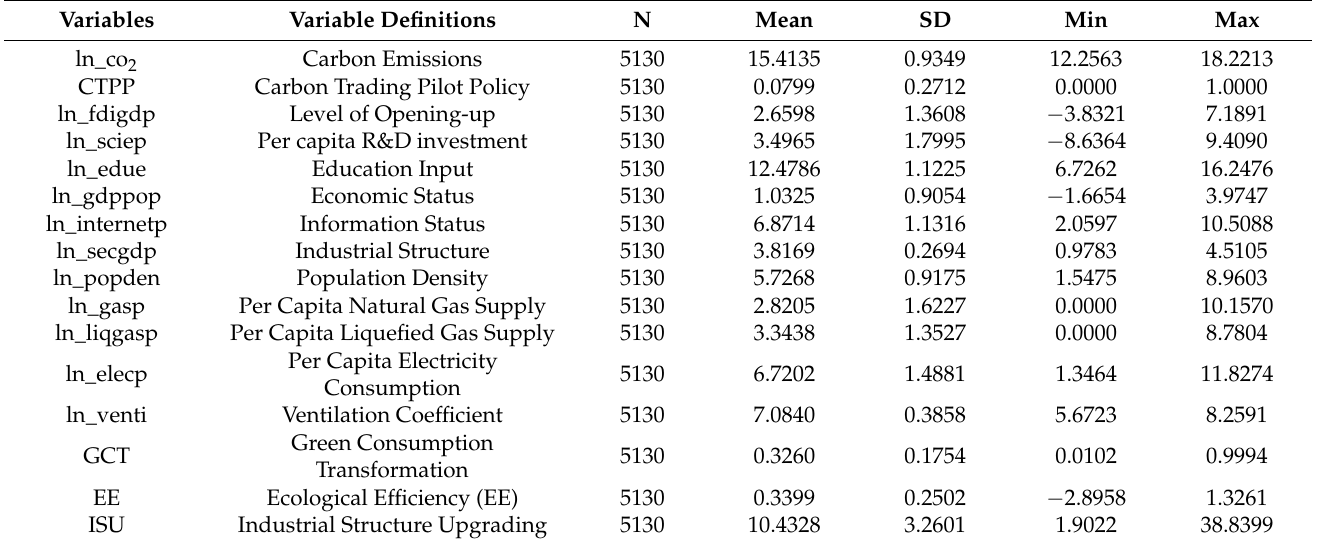
Table 1. Variable definitions and descriptive